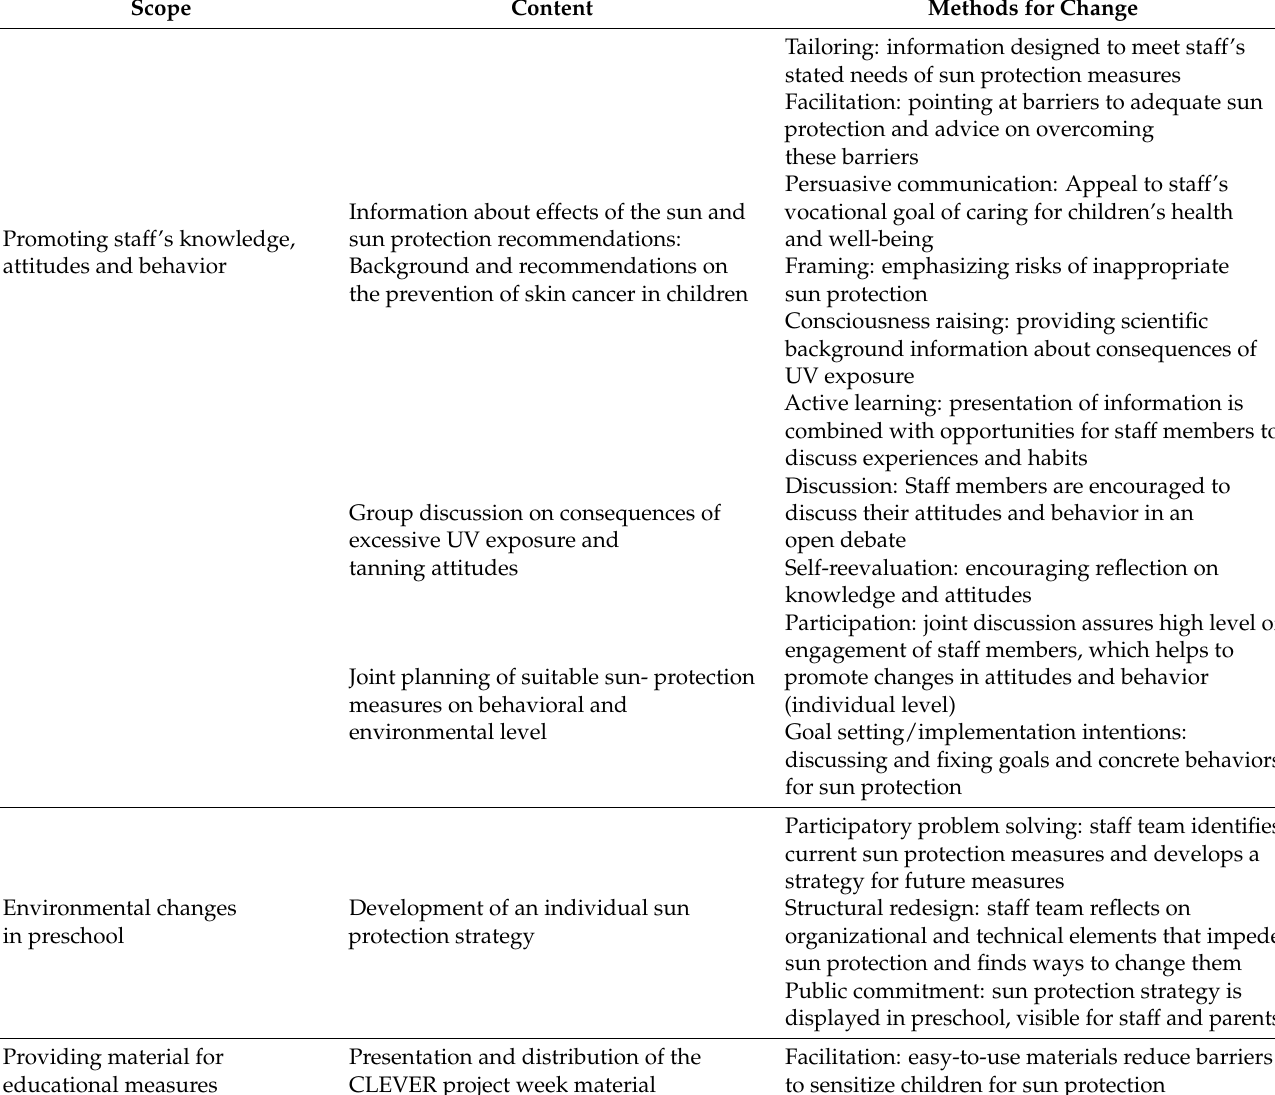
Table 2. Scope, content, and methods for change of the CLEVER team